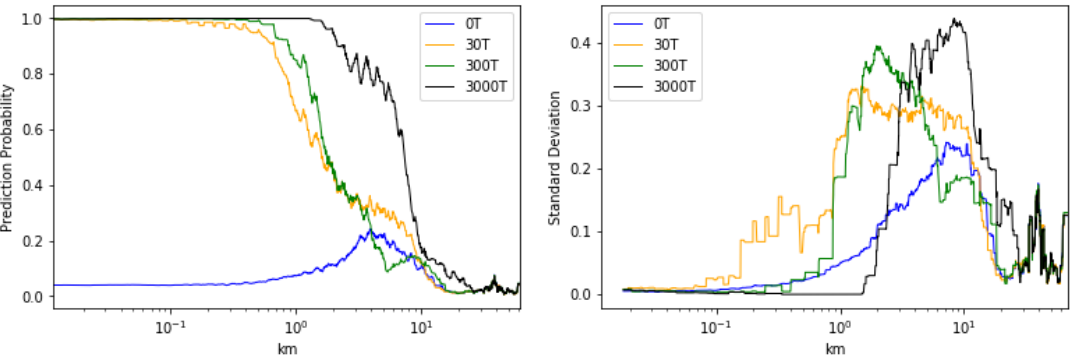
Figure 6. ( Right panel ) A moving mean of the prediction probability vs. the distance from the leakage. ( Left panel ) A moving standard deviation vs. the distance from the leakage. For the moving statistics, all points are evenly